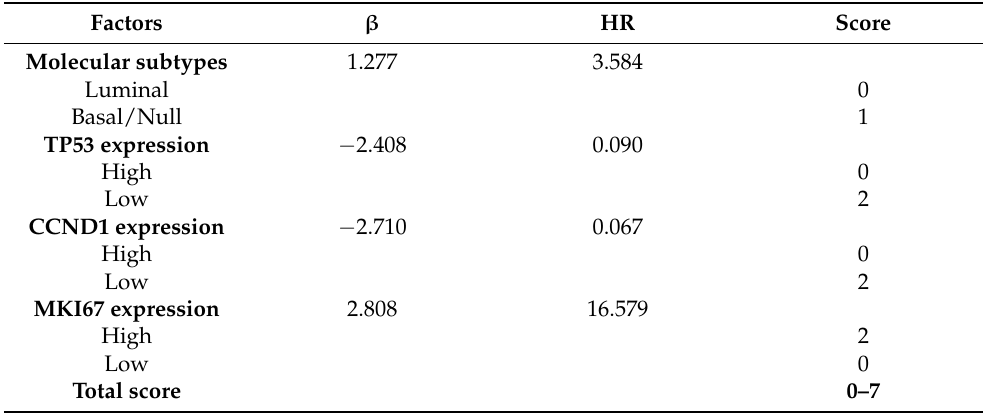
Table 4. Weights are used to calculate the risk scores associated with cancer-specific survival. The analysis allows calculating the patient’s risk scores [range, 0 (best prognosis) to 7 (worst prognosis)] (see also Figure 4A,B for details).